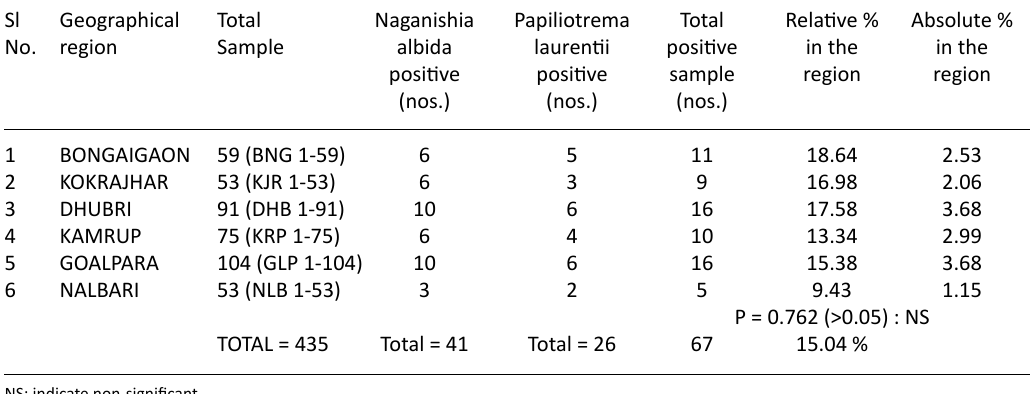
Table 8. Geographical co-ordinates and environmental niches wise frequency distribution of positive isolates of Cryptococcus